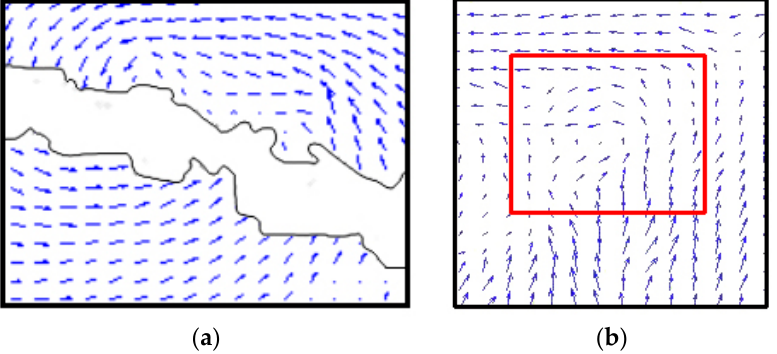
Figure 5. Examples of missing report and false alarm in the test results: ( a ) a cyclone lands on island, and is not detected by the model; ( b ) a turbulence that is recognized as anticlockwise cyclone.